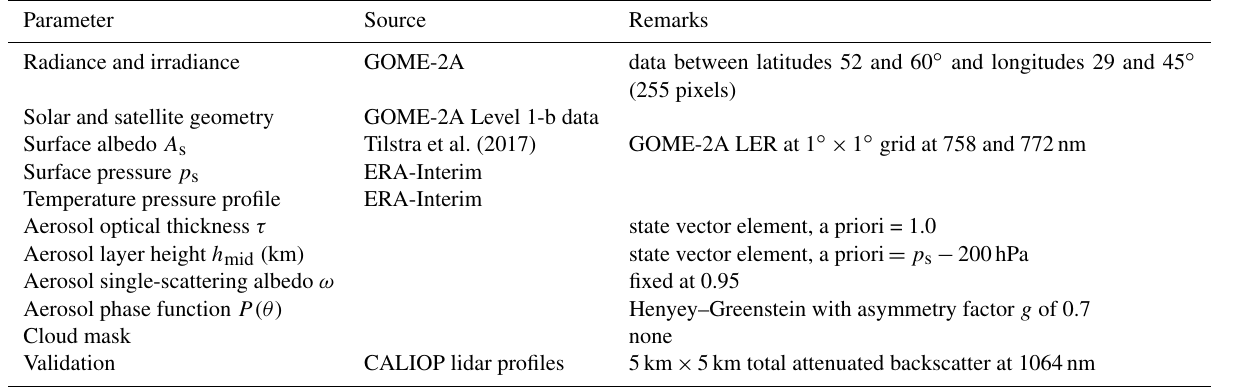
Table 1. A priori and validation information required to process data over 2010 Russian wildfires on 8 August